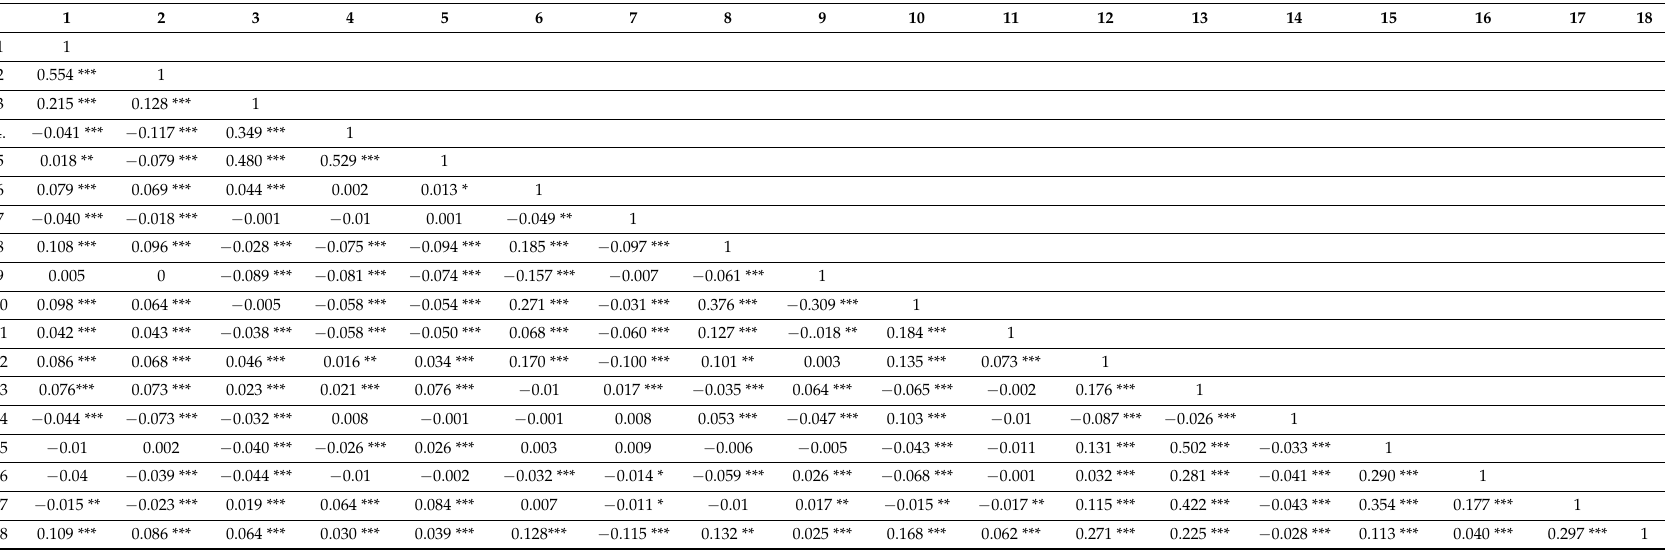
Table 3. Zero-order Pearson